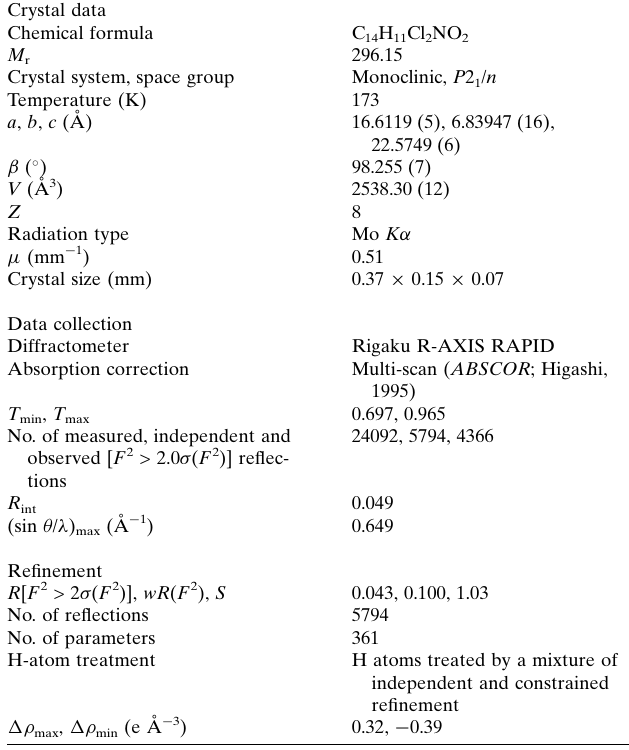
Table 2 Experimental details. Crystal data Chemical